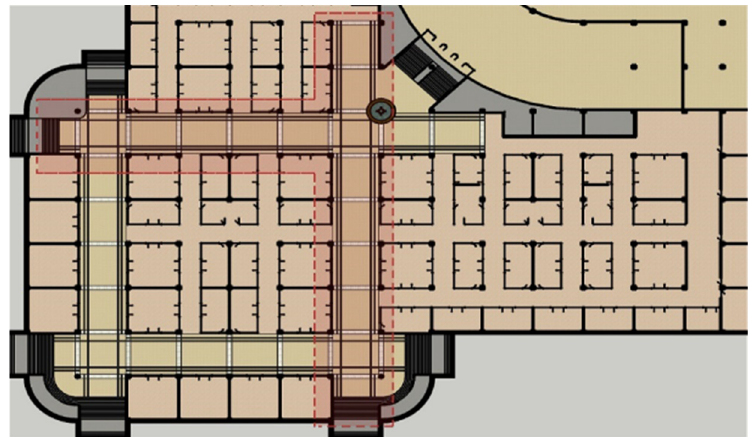
Figure 2. Fashion Avenue in Xuzhou.